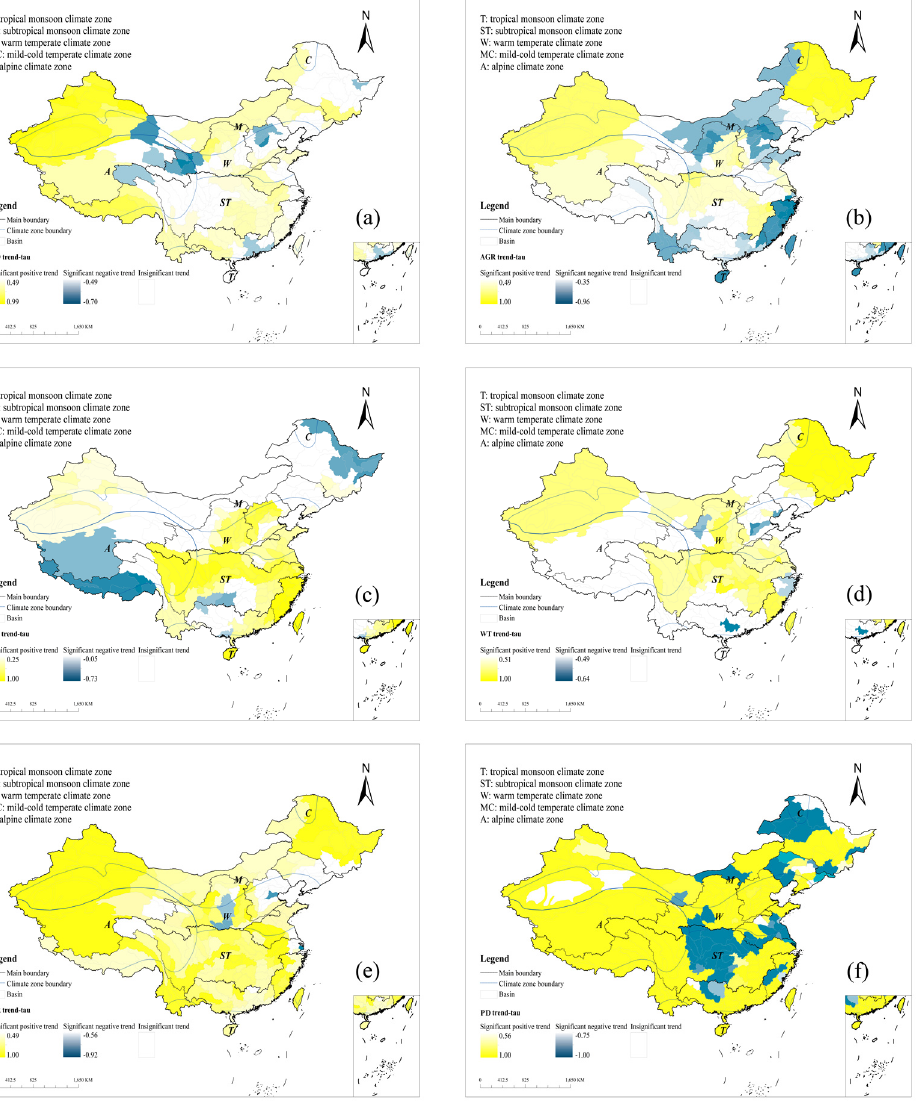
Figure A5. The spatial distributions of significant change trends ( p < 0.05) of ( a ) IND; ( b ) AGR; ( c ) DW; ( d ) WT; ( e ) IRR; and ( f ) PD .